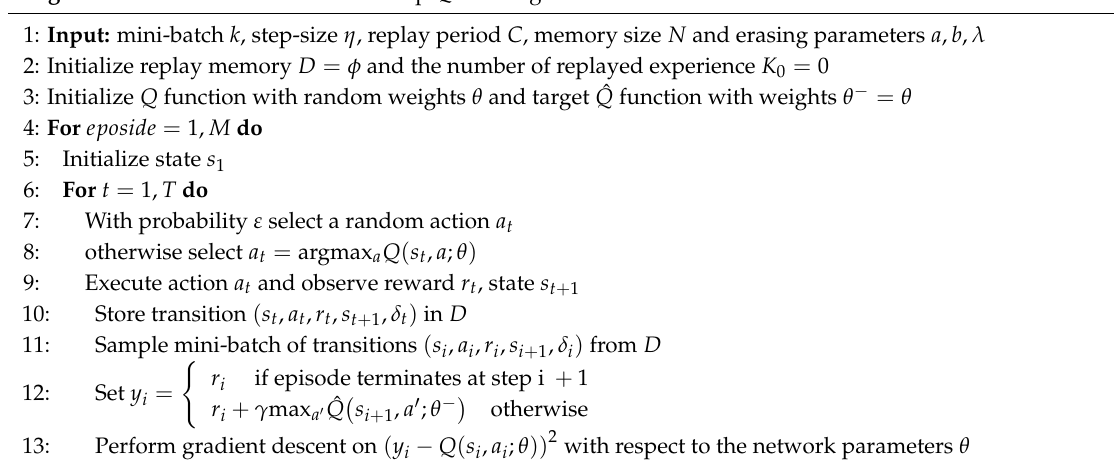
with respect to the network parameters 